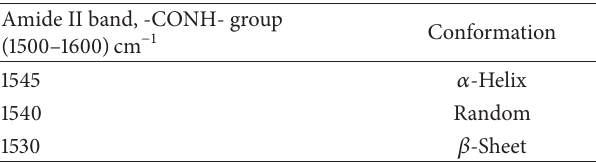
Table 2: Wavenumbers for estimation of secondary structure con- formation [27].